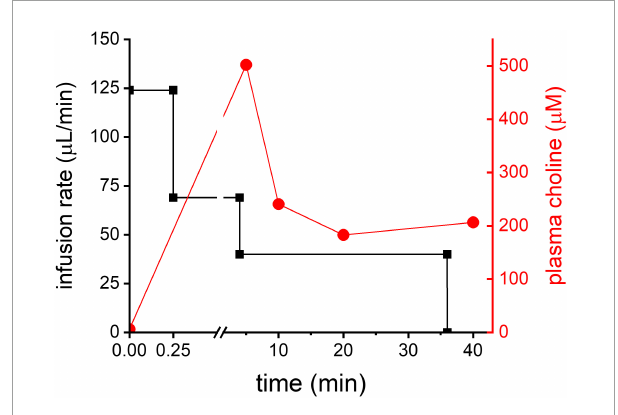
FIGURE2 Cho infusion. In black: 3-step infusion protocol graphically shown for an animal with body weight of 250 g (left Y-axis). In red: plasma Cho concentration (mM) measured in one animal using the infusion protocol shown in